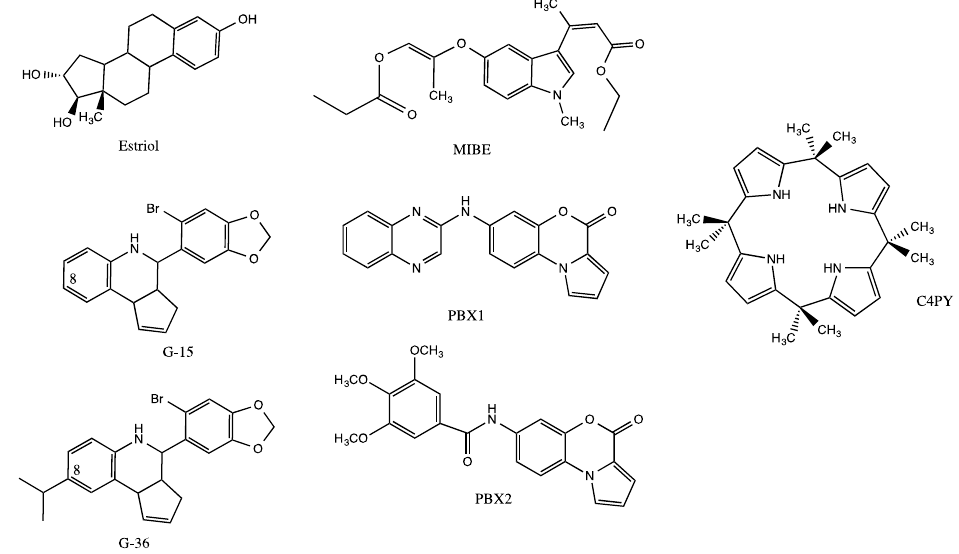
Figure 1. Structure of GPER antagonists.